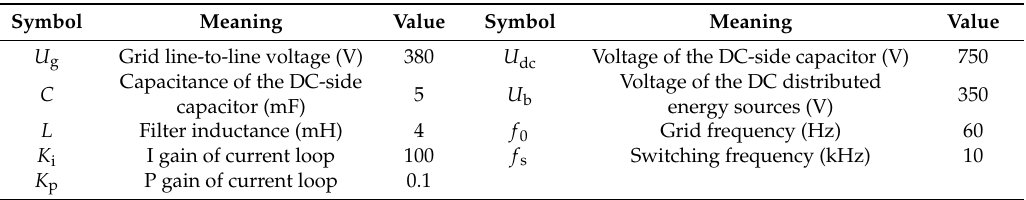
Table 1. Main parameters of the DC distributed power systems